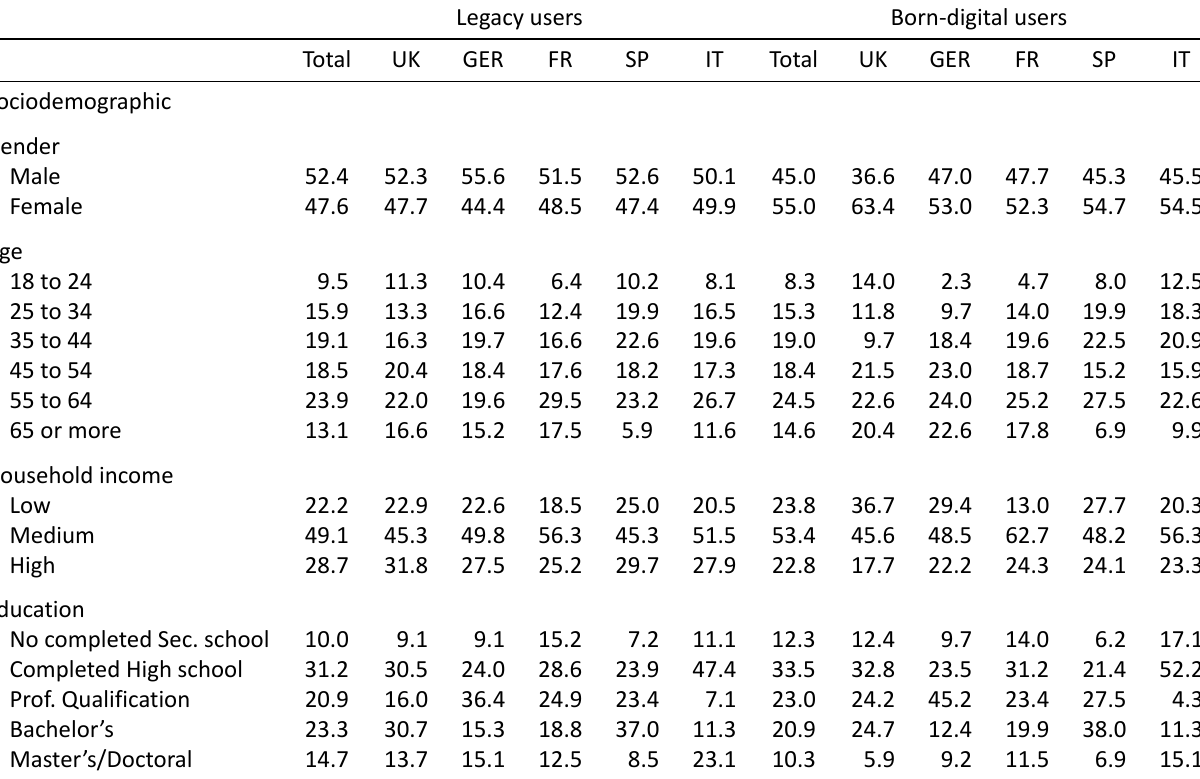
Table 3. Frequency distributions for sociodemographic variables, 2015 (%).